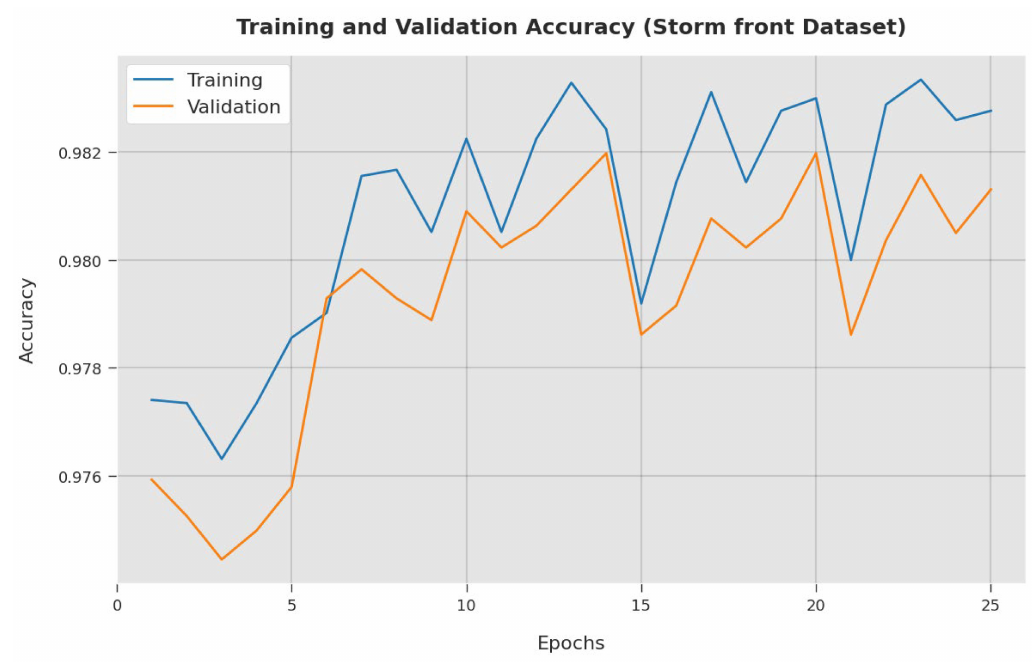
Figure 11. TA and VA analysis of ESGONLP-HSC algorithm under the Storm front dataset. The training loss (TL) and validation loss (VL) achieved by the ESGONLP-HSC algo- rithm on the Storm front dataset are established in Figure 12. The experimental outcome inferred that the ESGONLP-HSC technique has accomplished the lowest values of TL and VL. In particular, the VL seemed to be lower than TL.